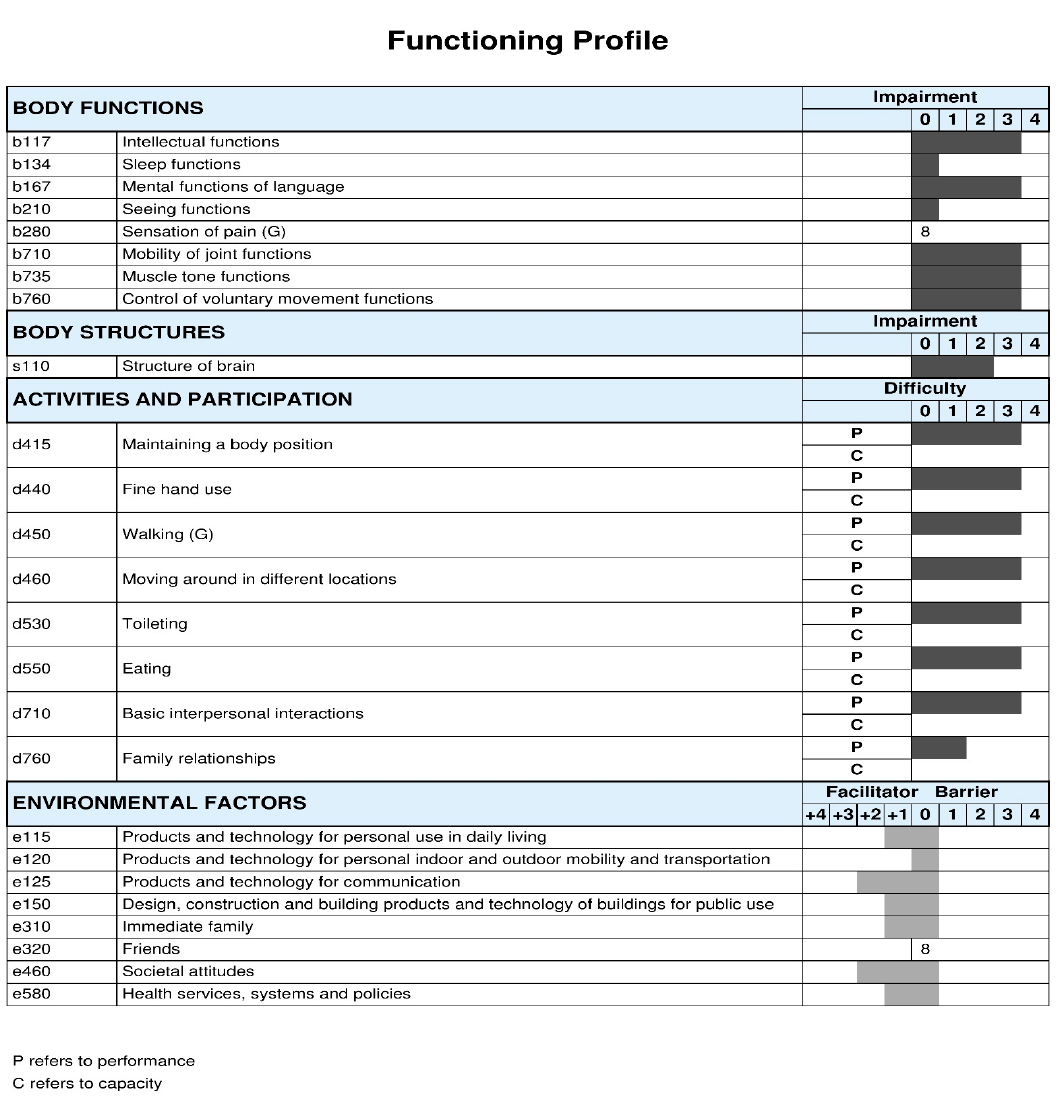
Figure 4. Functioning profile of the Russian children, GMFCS levels IV to V. The ICF qualifiers use to create the profile of functioning of this study sample represent the qualifiers that have the highest percentage within each ICF category